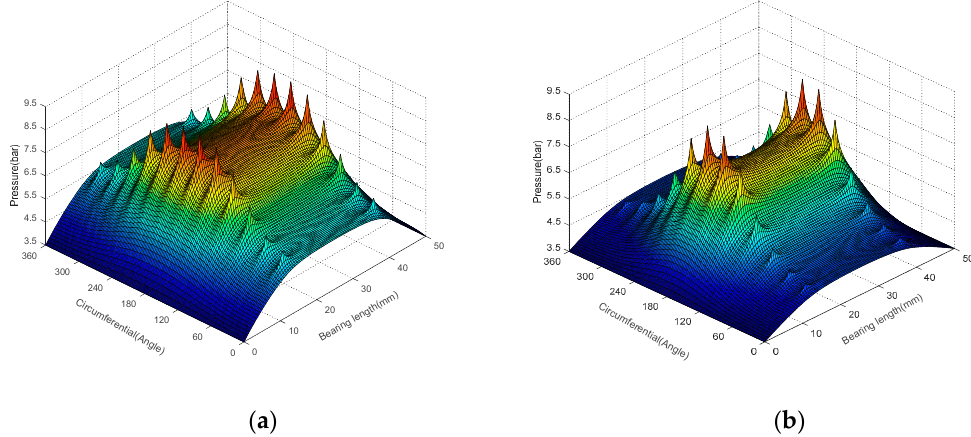
Figure 5. Pressure distribution of journal bearing ( ω = 0, ε = 0.5, p s = 0.95 MPa, h 0 = 20 μ m, d = 0.3 mm) ( a ) air ( b ) R134a.